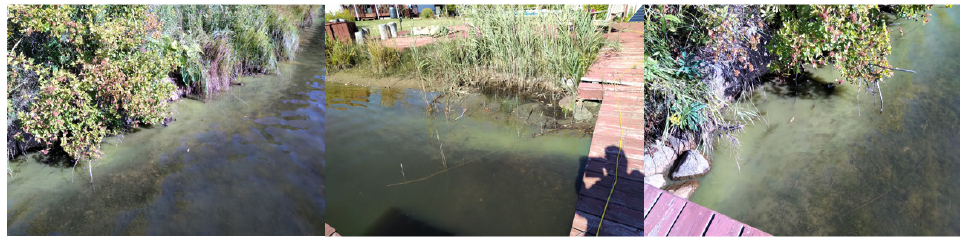
Figure 9. Floating phytoplankton in Lake Caron in the 2020 summer study.